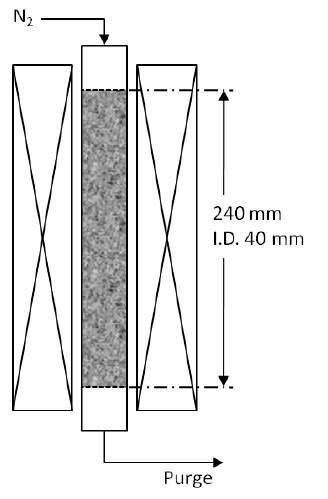
Figure 1. Char preparation by pyrolysis at 600, 800 and 1000 °C.